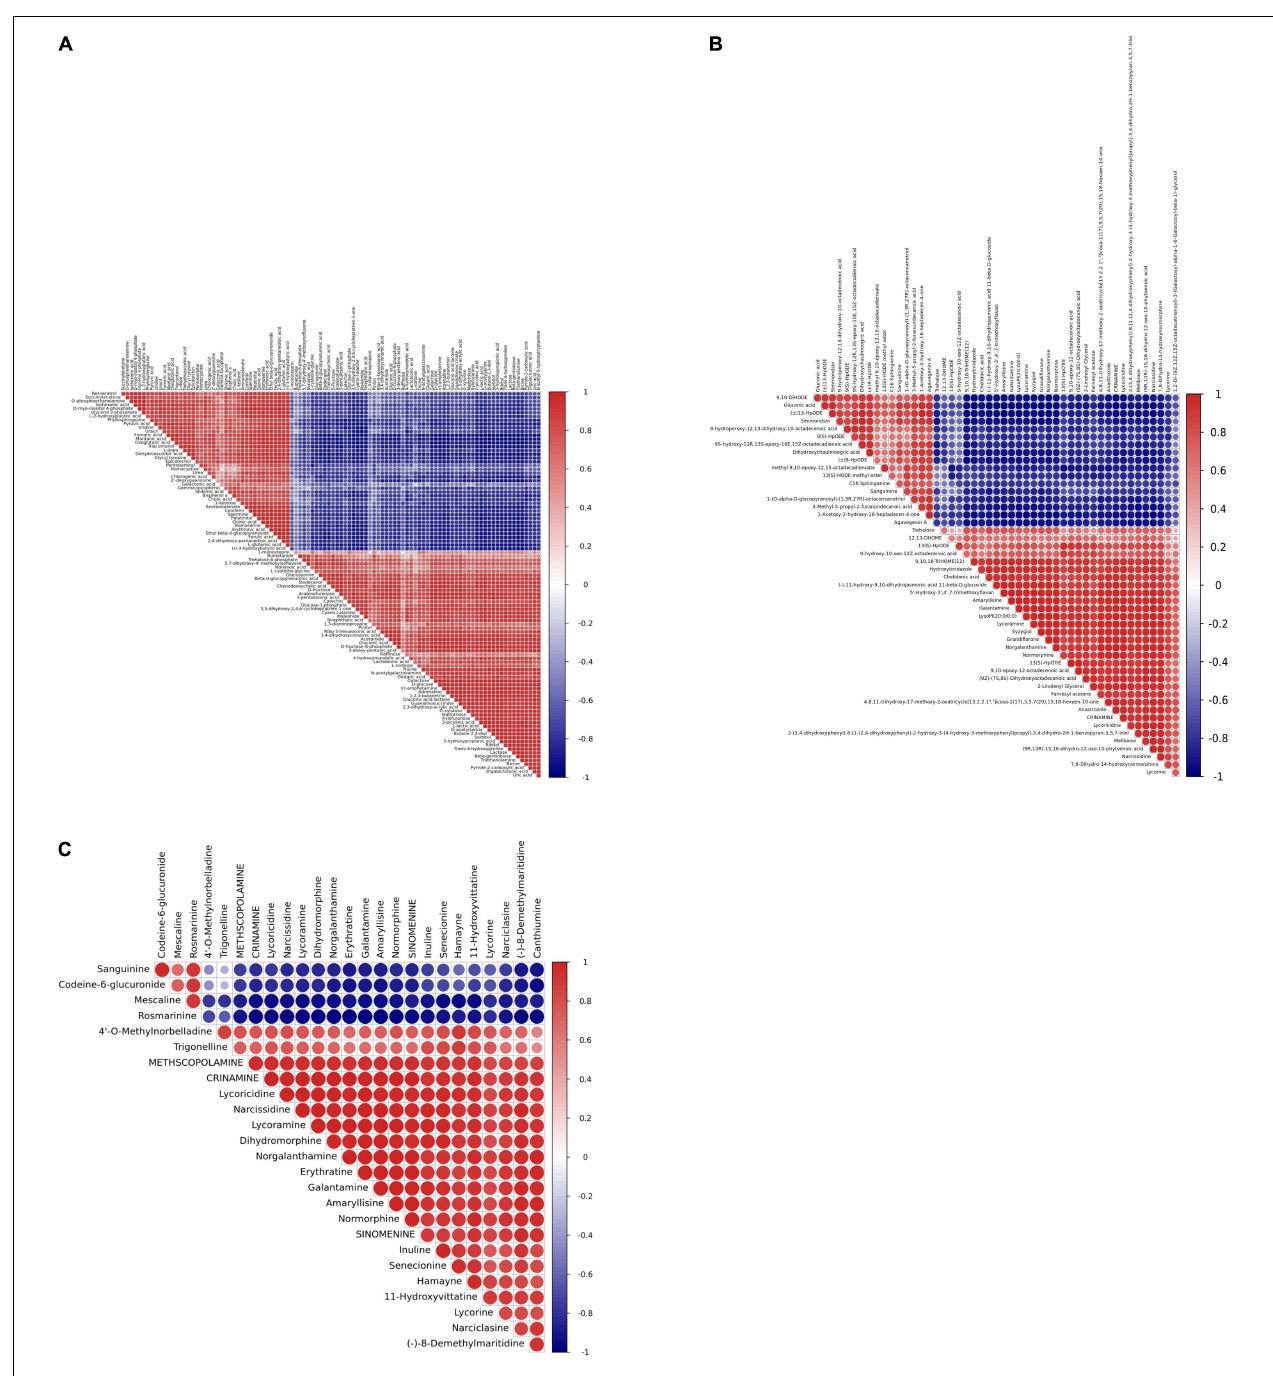
FIGURE 12 | Heat map representing the r coefficients for the identified metabolites in L. longituba seedlings after MJ-75 and MJ-0 treatments. Correlations showed the 103 metabolites identified by GC-MS (A) , the top 50 statistical significance of all identified metabolites by LC-MS (B) , and statistical significance of alkaloids identified by LC-MS (C) . They are analyzed by using a Pearson correlation coefficient method. In the colored area, rectangles represent Pearson correlation coefficient ( r ) values of metabolites pair ( N = 6).